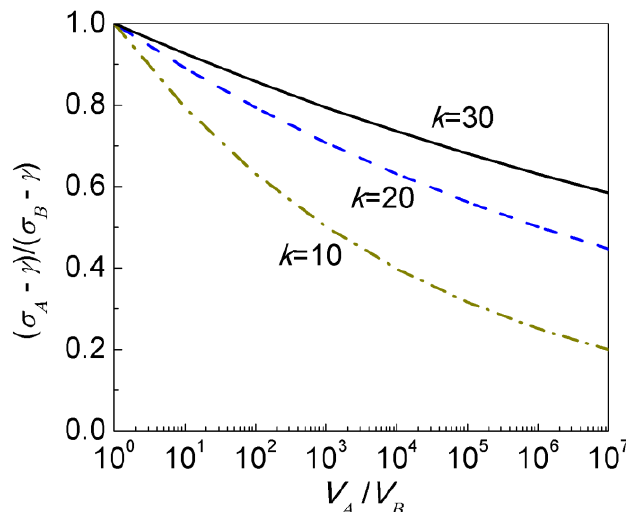
Figure 6. Value of ( σ A − γ )/( σ B − γ ) versus V A / V B in Equation (7) at different shape parameter k .